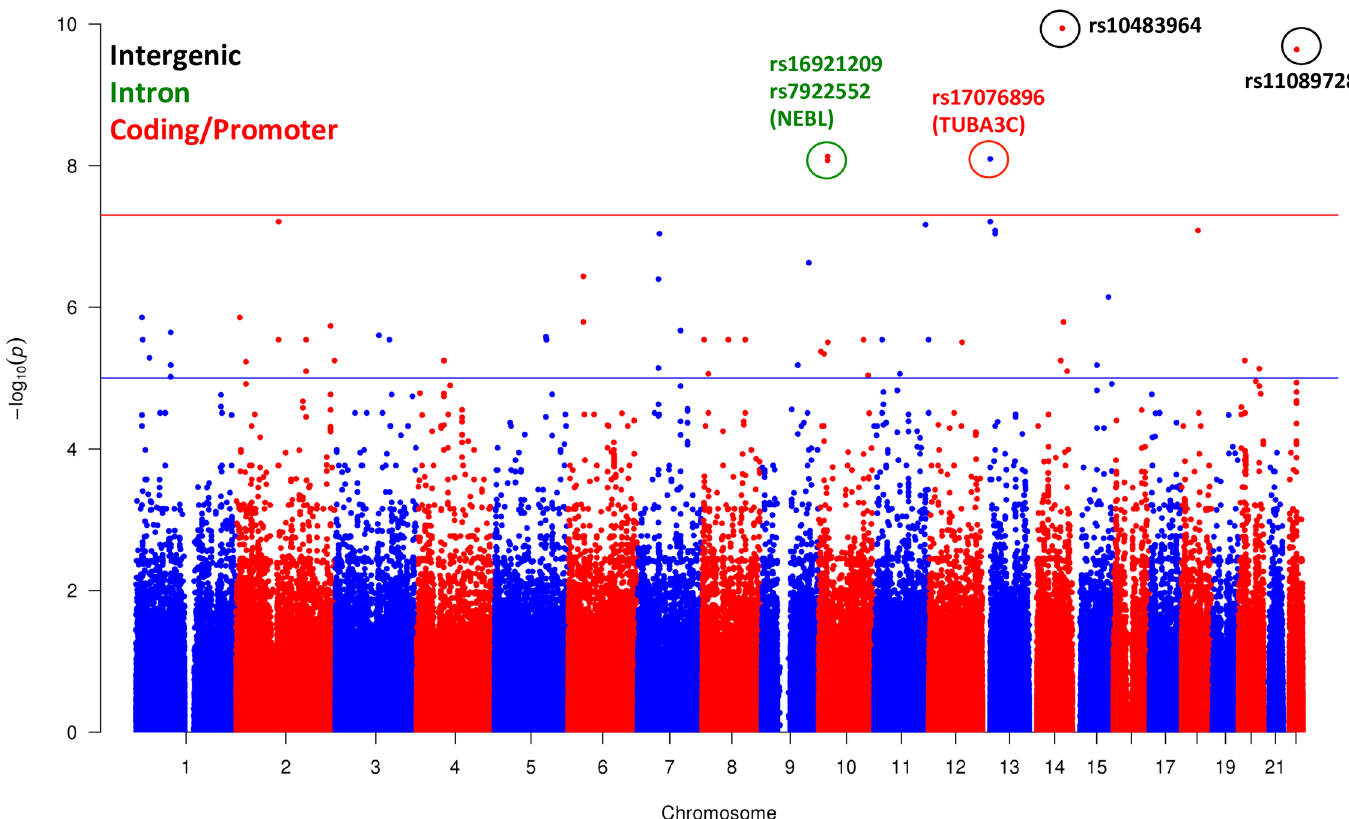
Fig 1. Manhattan plot of the association between SNPs and susceptibility of CAA formation in KD. The − log 10 P -values of significance shown in chromosomal order for qualified 559,602 SNPs tested for association in initial sample of 11 KD patients with CAA and 146 KD ones without CAA. The x-axis represents each of the SNPs used in the primary scan according to their genomic location. The y-axis indicates the − log 10 P -values of the trend test. Horizontal lines indicate the general and stringent thresholds of − log 10 P as 5 and 7, respectively.